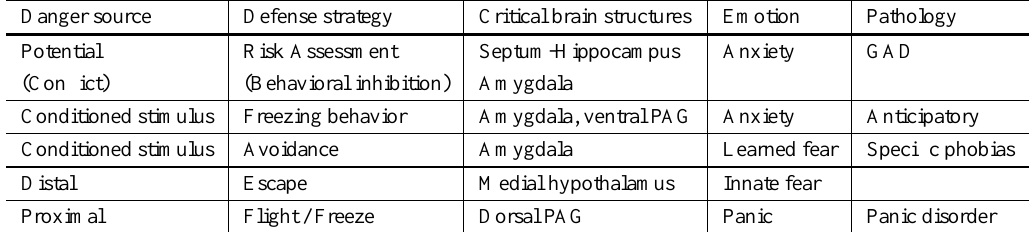
Correlation among defense strategies, anxiety-like emotions and their